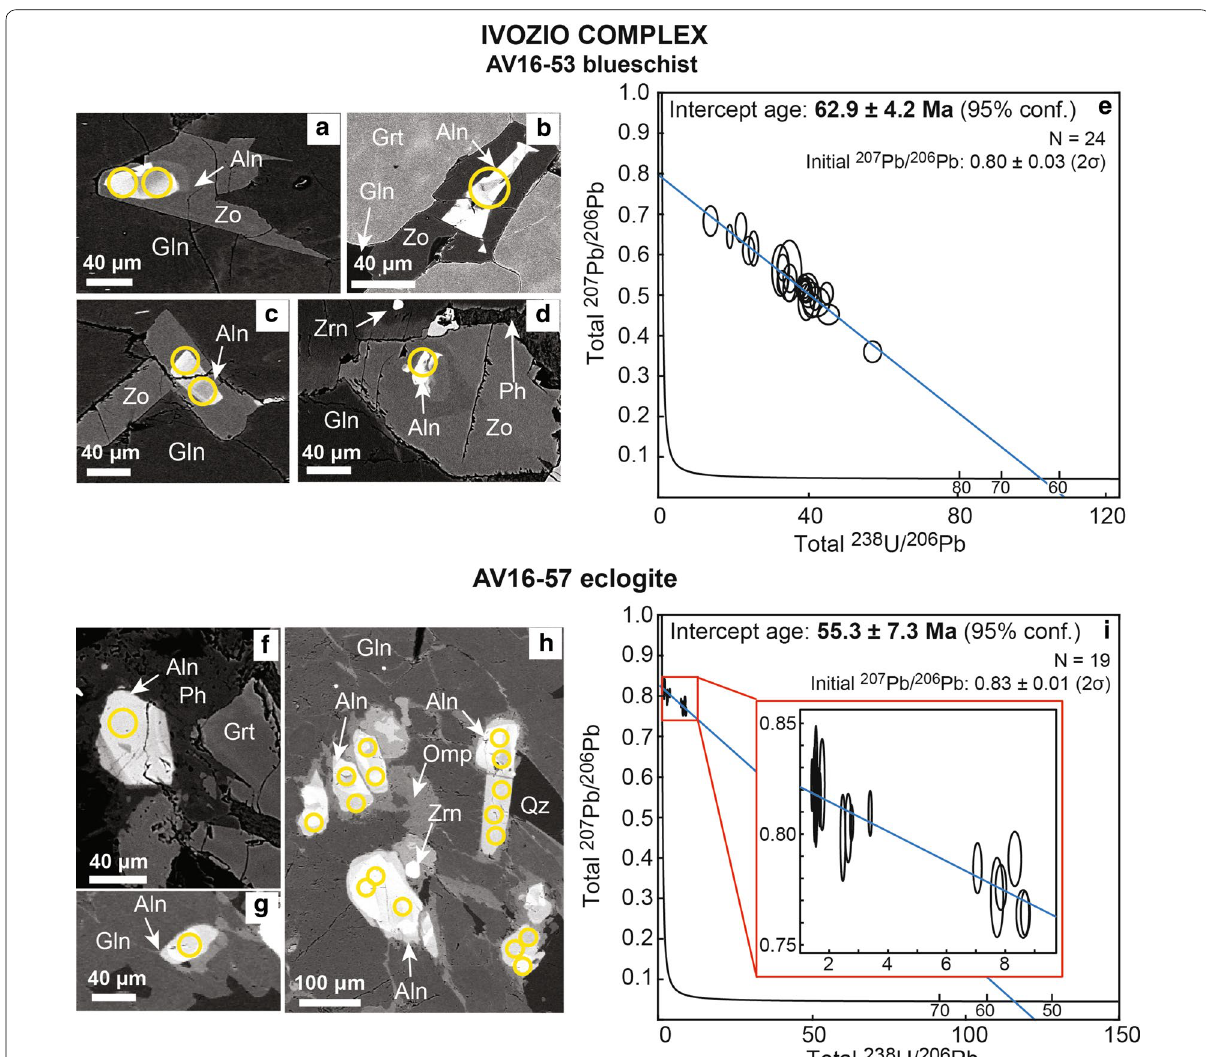
Fig. 8 Allanite in samples from Ivozio Complex. Blueschist AV16-53: a – d Thin section BSE images of zoned allanite (Aln) with a zoisite rim (Zo), associated to glaucophane (Gln) and, to a minor extent, to garnet (Grt) and phengite (Ph). Zircon (Zrn) < 10 μm in size are present. Yellow circles represent analysed spots. e Tera-Wasserburg plot for LA-ICP-MS U–Pb allanite analyses. Data-point error ellipses are 2σ. Eclogite AV16-57: f – h Thin section BSE images of zoned allanite (Aln) associated to glaucophane (Gln) and phengite (Ph). Garnet (Grt) is fractured and partially resorbed. Quartz (Qz) and μm-size zircons (Zrn) are also present. Yellow circles represent analysed spots. i Tera-Wasserburg plot for LA-ICP-MS U–Pb allanite analyses. Data-point error ellipses are